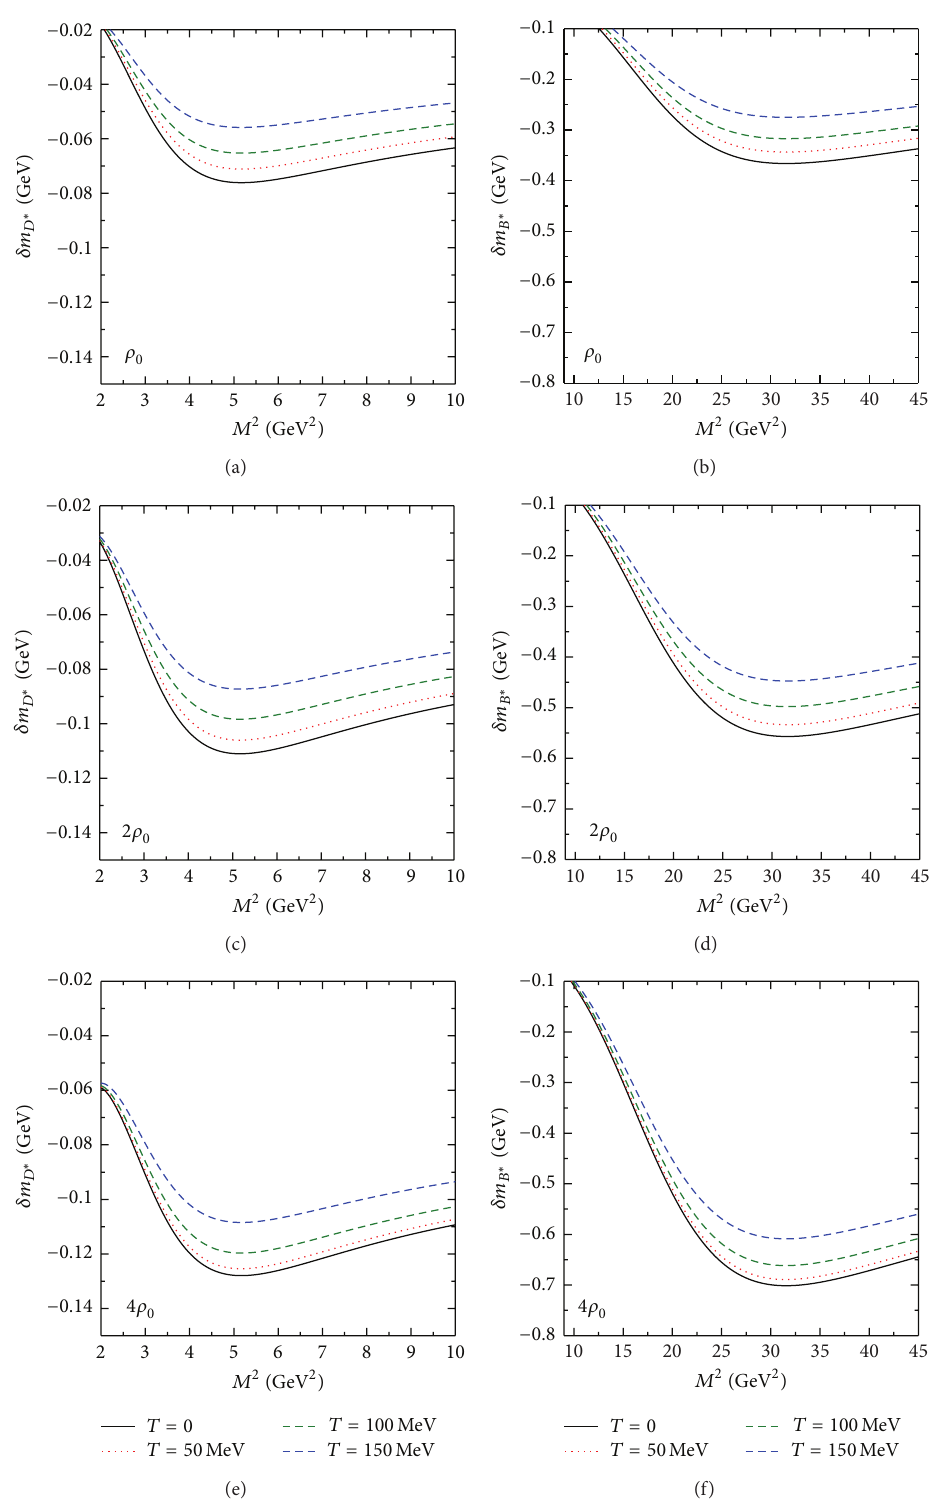
Figure 4: (Color online) Figure shows the variation of the mass shift of vector mesons 𝐷 ∗ (subplots (a), (c), and (e)) and 𝐵 ∗ (subplots (b), (d), and (f)) as a function of the squared Borel mass parameter, 𝑀 2 . We have shown the results at baryon densities 𝜌 0 , 2𝜌 0 , and 4𝜌 0 . For each value of the baryon density the results are shown at temperatures, 𝑇 = 0, 50, 100, and